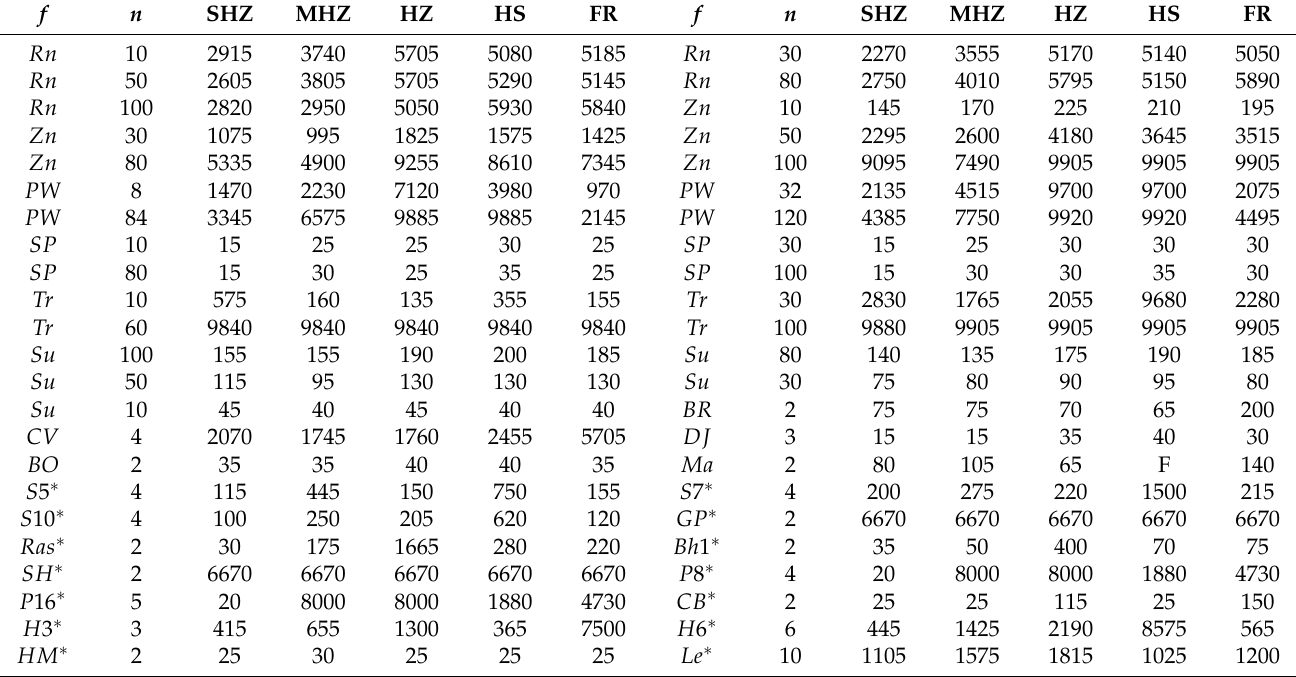
Table 2. The number of worst